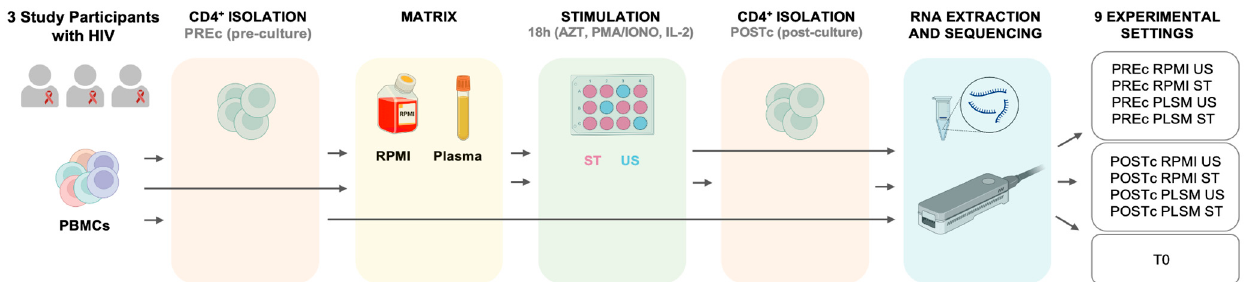
Figure 1. Experimental design depicting the sequence followed to investigate the expression of the CD4 + T cells genes from 3 young adult donors with perinatal HIV and in 9 different experimental settings. Lymphocytes were isolated from PMBCs before or after culture (respectively, PREc and POSTc) and stimulated in the presence of PMA/ionomycin, AZT, and IL-2 (ST), or left unstimulated for 18 h (US) in plasma (PLSM) or RPMI. An additional sample of uncultured CD4 + T cells (T0) was collected as a transcriptional basal state. Total RNA was extracted and sequenced using Oxford Nanopore technology.